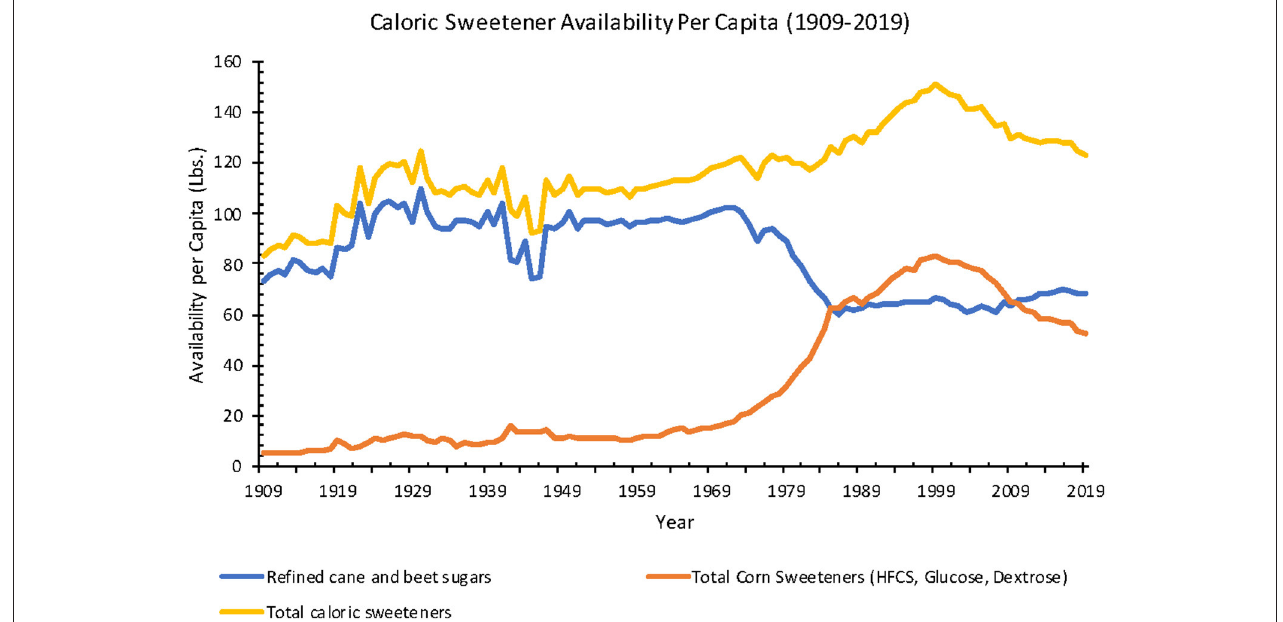
FIGURE 10 | Annual caloric sweetener availability per capita from 1909 to 2010 in the United States of America (Source: USDA ERS) .